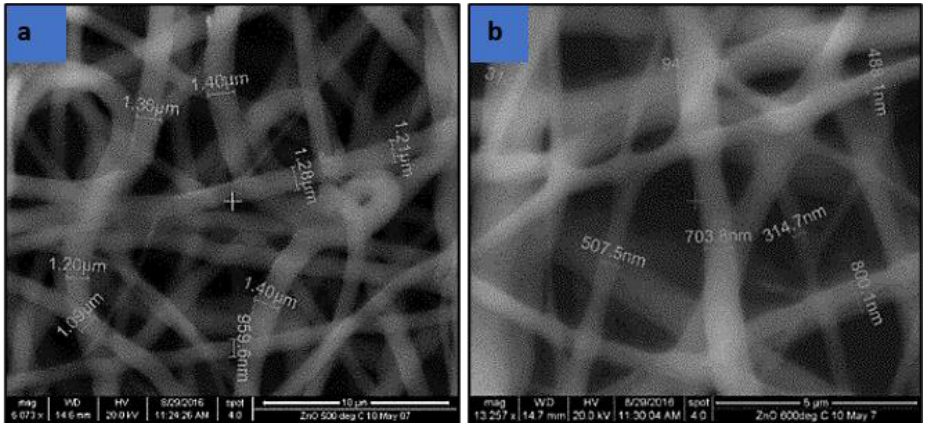
Figure 22. ( a ) Fiber mats using 18G needle magnified at 10 µm and ( b ) using 22G needle magnified at 5 µm [ 171 ]